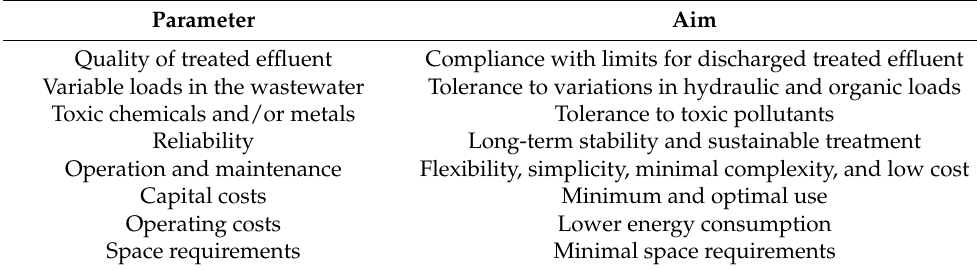
Table 1. Main deciding factors for choosing a wastewater treatment